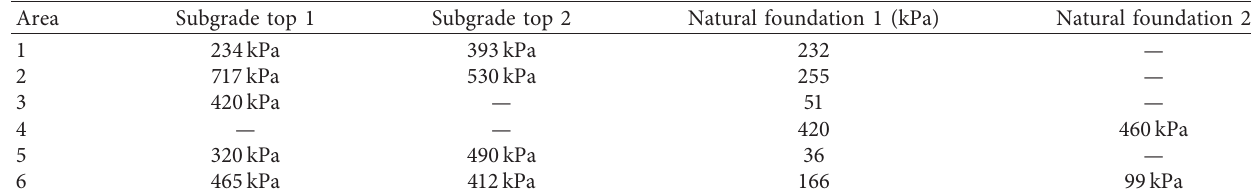
Table 6: Calculated allowance bearing capacity in each testing